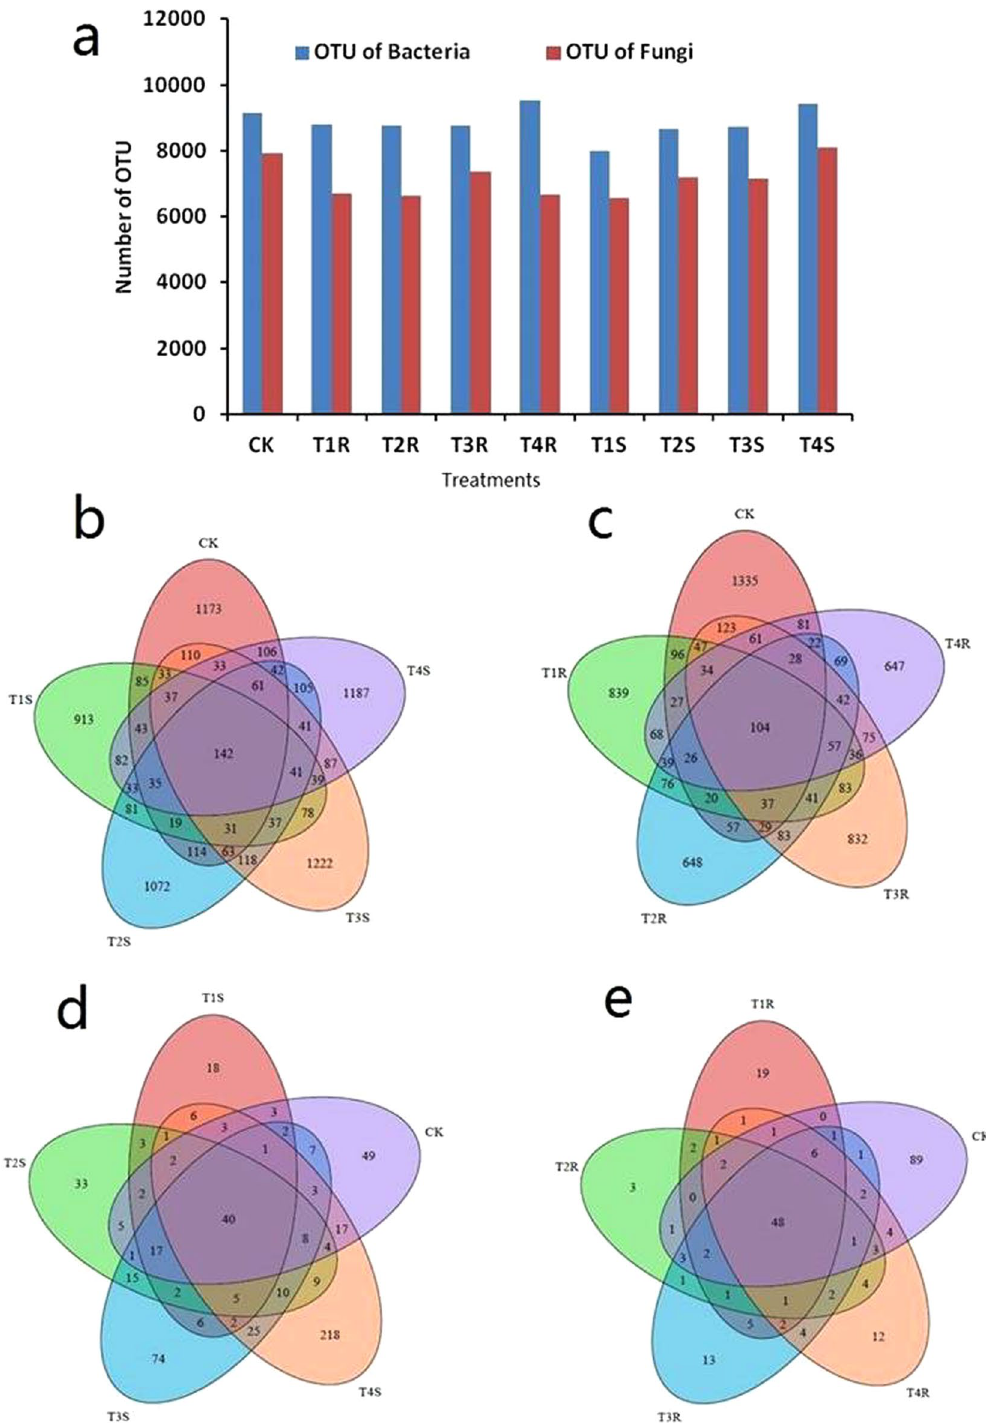
Figure 3. The distribution of operational taxanomical units (OTUs) found in maize root and rhizosphere soil with different treatment of Trichoderma and FG. (CK-unsterilized natural agriculture field soil,T1S- uninoculated soil, T2S-Soil inoculated with T. harzianum strain CCTCC-RW0024, T3S-Soli inoculated with FG, T4S-Soil inoculated with T. harzianum strain CCTCC-RW0024 and FG, T1R Maize root samples collected from uninoculated soil pot, T2R maize root collected from soil inoculated with T. harzianum strain CCTCC-RW0024, T3R- Maize root samples collected from inoculated with FG pot, T4R- Maize root samples collected from inoculated with T. harzianum strain CCTCC-RW0024 and